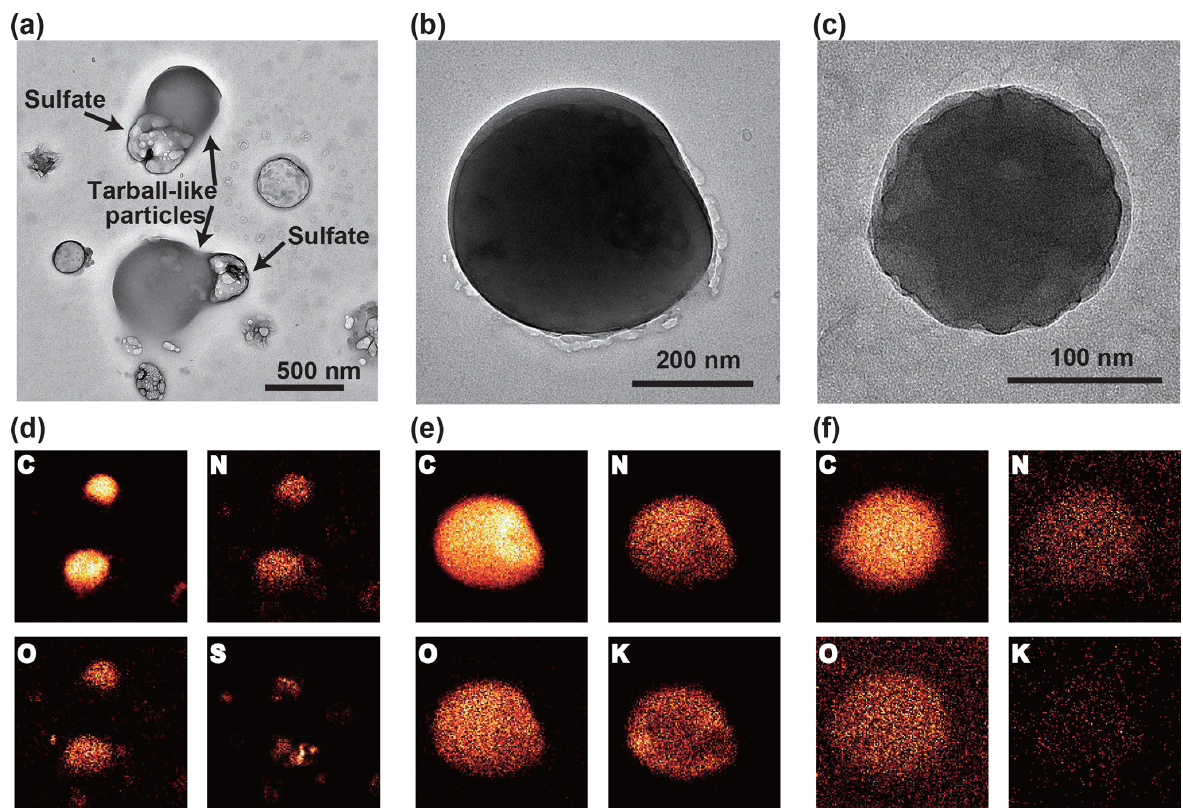
Figure 12. TEM and elemental mapping images of the tarball and tarball-like particles in a BB sample (10:30–10:59UTC, 2 April 2018). (a) TEM image of the tarball-like particles containing sulfate. As they exhibit deformed spherical shapes and the characteristic elements of tarballs (e.g., C, N, O, and K), we label them tarball-like particles. Other examples of tarballs are shown in panels (b) and (c) . (d–f) Elemental mapping images of the TEM